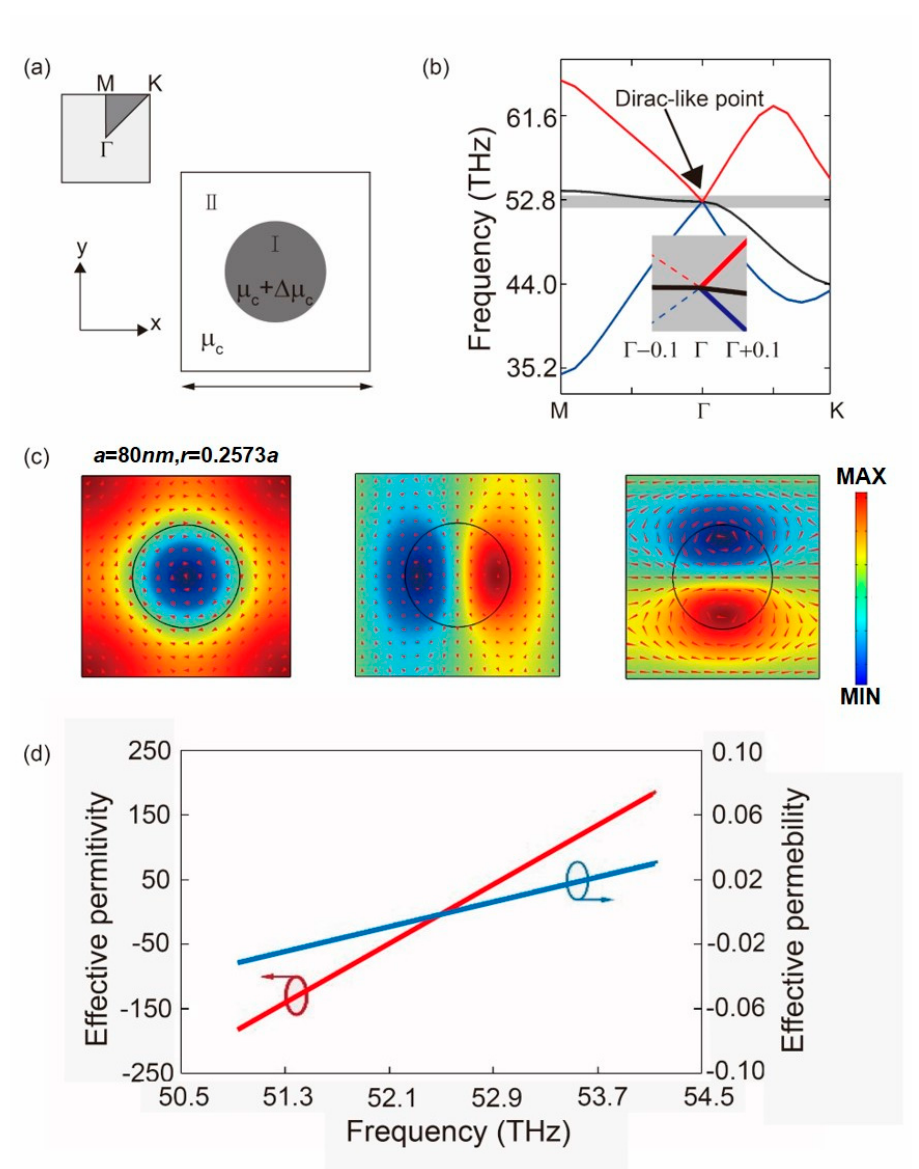
Figure 2. Schematic of the graphene metamaterials (GMMs) and band structure. ( a ) Proposed graphene metamaterials (GMMs) in real and reciprocal space. The chemical potential of the graphene nanodisk (region I) and the ambient graphene (region II) are µ c + ∆ µ c and µ c , respectively and the Brillouin zone corresponding to the square-shaped unit cell is placed in the upper left corner; ( b ) The band structure of the proposed GMMs and the illustration is the detailed information around the Dirac-like point; ( c ) The eigen electric fields including two dipolar modes and a single monopole mode the arrow indicate the eigen magnetic fields; ( d ) e ff ective permittivity and permeability of the GMMs.